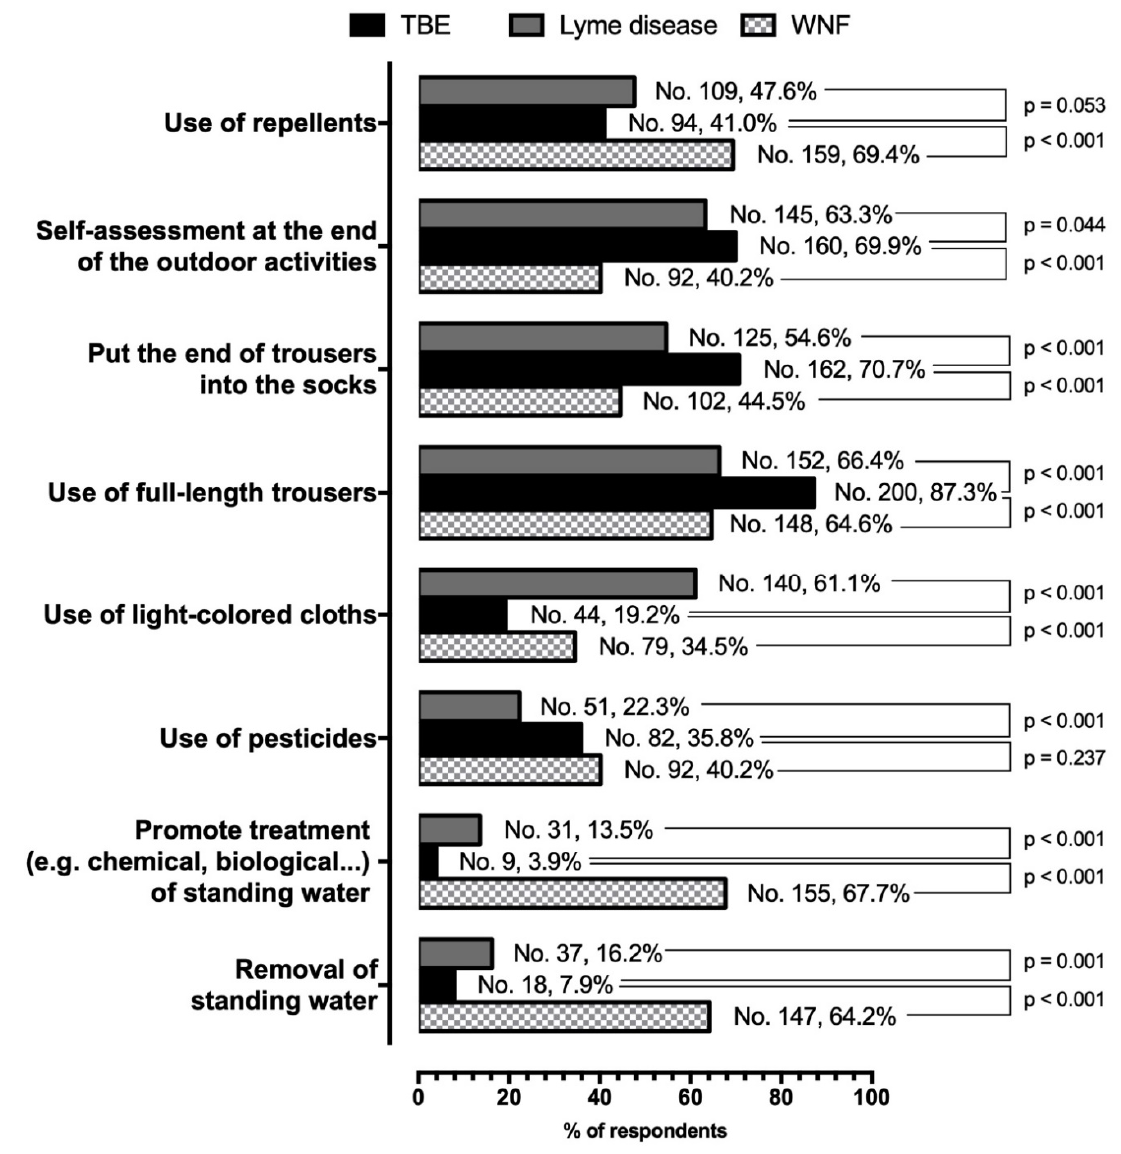
Figure 1. Prevalence of protective practices for TBE, Lyme disease, and West Nile Fever (WNF) reportedly recommended by 229 Occupational Physicians participating in the survey, compared by means of McNemar test for paired